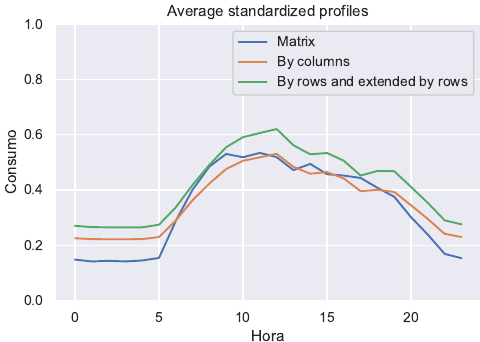
Figure 2. Average profiles of the standardized records.